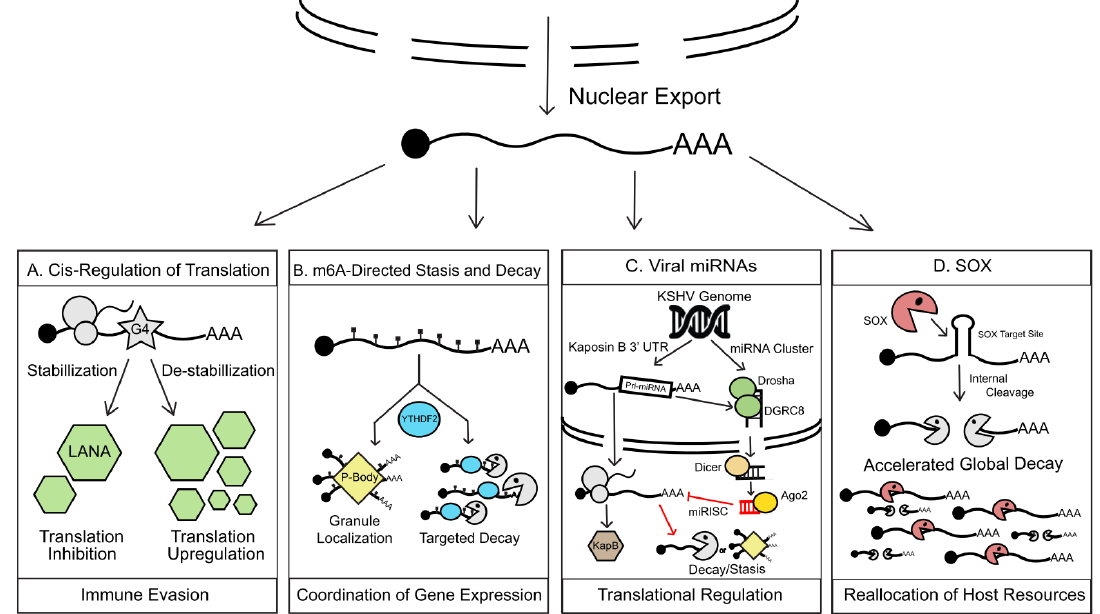
Figure 2. KSHV manipulation of cytoplasmic RNA regulation. ( A ) G4s found within cytoplasmic LANA transcripts, when stabilized, inhibit LANA translation, which in turn reduces antigenic presentation aiding in immune evasion during KSHV latency. ( B ). The fate of m 6 a modified viral transcripts in the cytoplasm is modulated by m 6 a readers. These readers, including YTHDF2 (YTH N6-Methyladenosine RNA Binding Protein 2), orchestrate silencing and / or degradation of modified mRNAs by driving their localization to cytoplasmic RNA granules such as P-bodies or recruitment of host exonucleases. Co-opting of this m 6 a machinery allows KSHV an unprecedented level of control over temporal viral gene expression. ( C ) KSHV encodes a large repertoire of viral miRNA. Taking advantage of the cellular miRNA silencing complex (RISC), viral miRNAs regulate translation of viral and host transcripts in trans by redirecting their localization to RNA granules for homeostasis or immediately triggering RNA decay. As a form of cis-regulation of a viral transcript, KSHV also co-opts cellular miRNA biogenesis machinery, namely DROSHA, to restrict the over-production of KapB during latency, which contributes to cell survival during latency and temporal regulation of KapB. ( D ) To swiftly seize control of the cell during lytic reactivation, KSHV encodes a viral endonuclease, SOX, which triggers a global RNA decay event. SOX selectively cleaves host and viral transcripts that bear conserved SOX recognition sites, rending transcripts susceptible to decay by cellular exonucleases. This massive degradation event releases host resources such as the translation machinery and RNA-binding proteins for reallocation to viral gene expression.